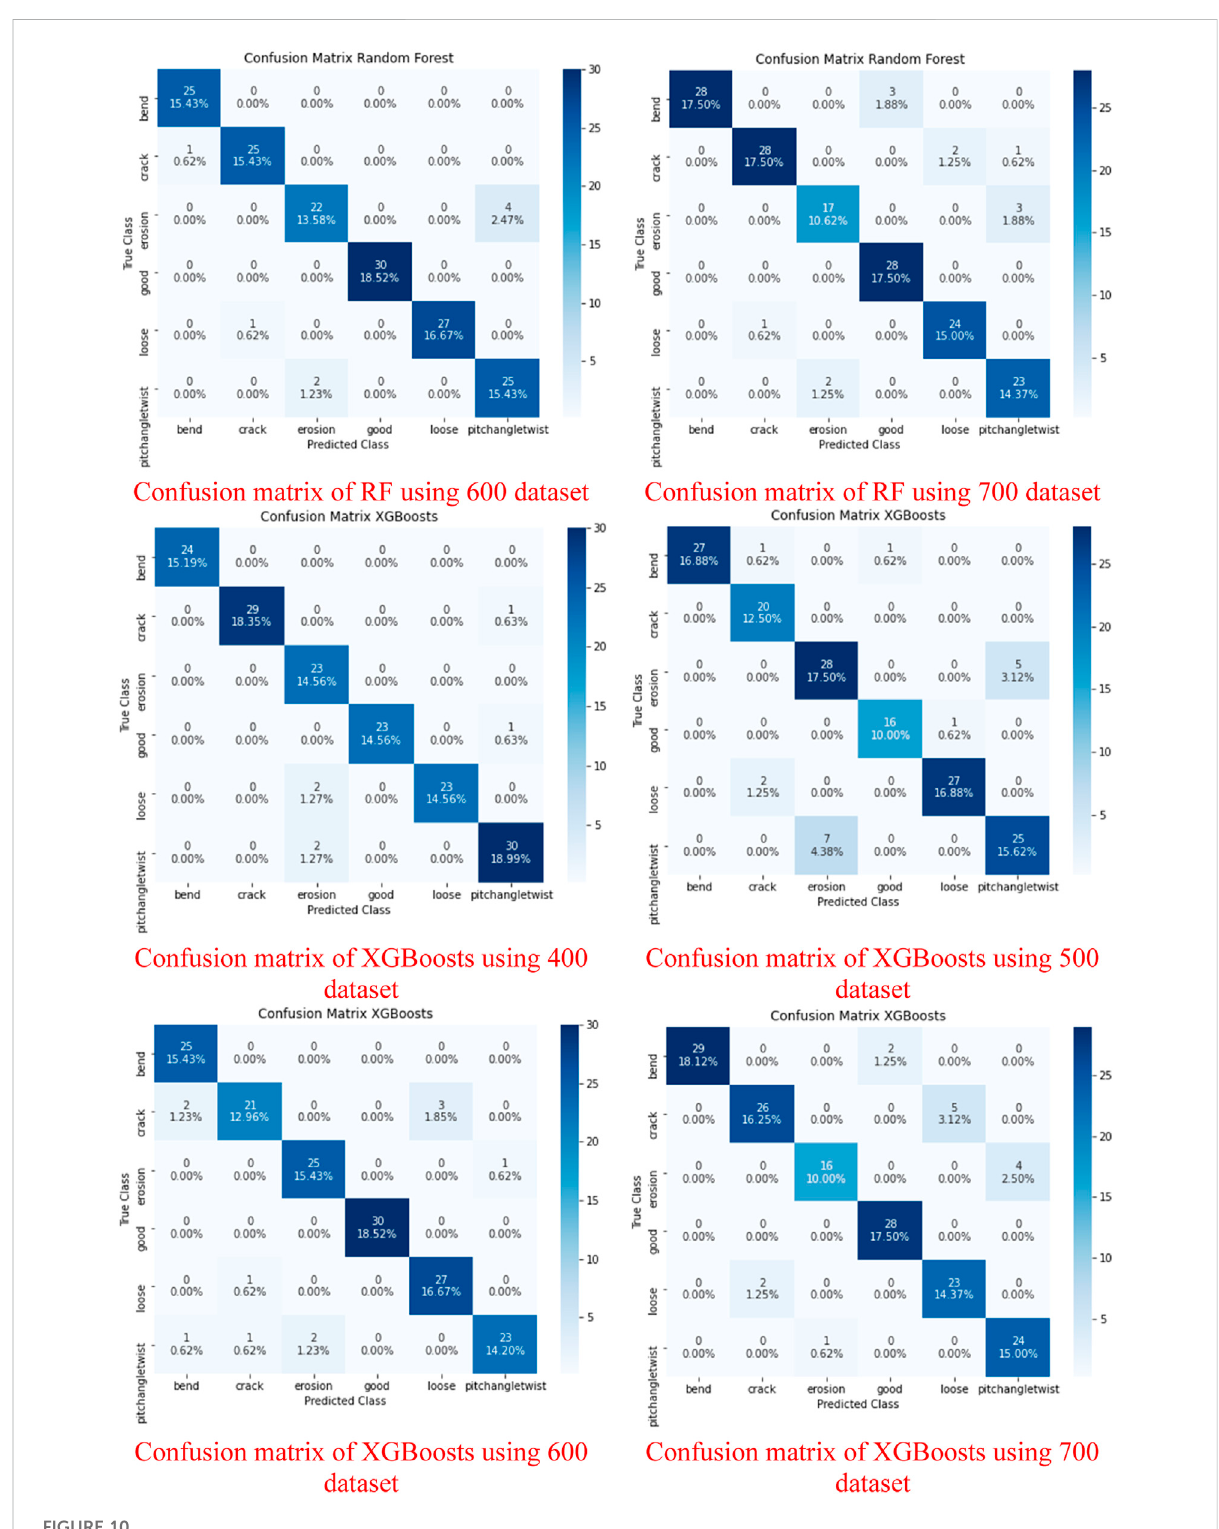
FIGURE 10 Confusion matrix of 1DCNN, bagging, decision tree J48, linear support vector machine, multilayer perception, naïve Bayes, random forest, and XGBoosts for (A) 400, (B) 500, (C) 600, and (D) 700